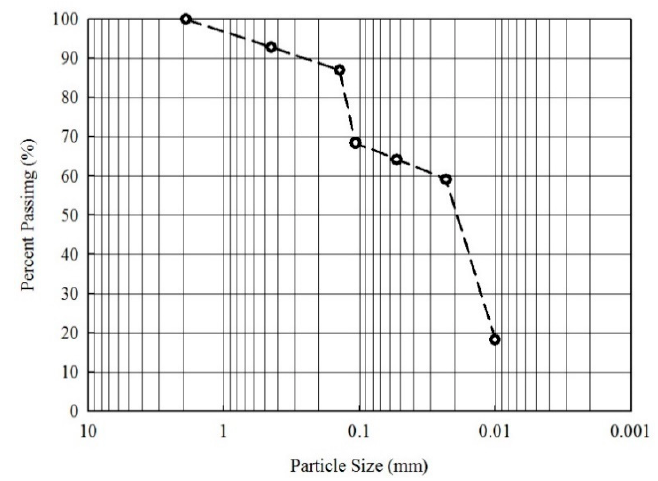
Figure 2. Particle-size distribution of contaminated soil.